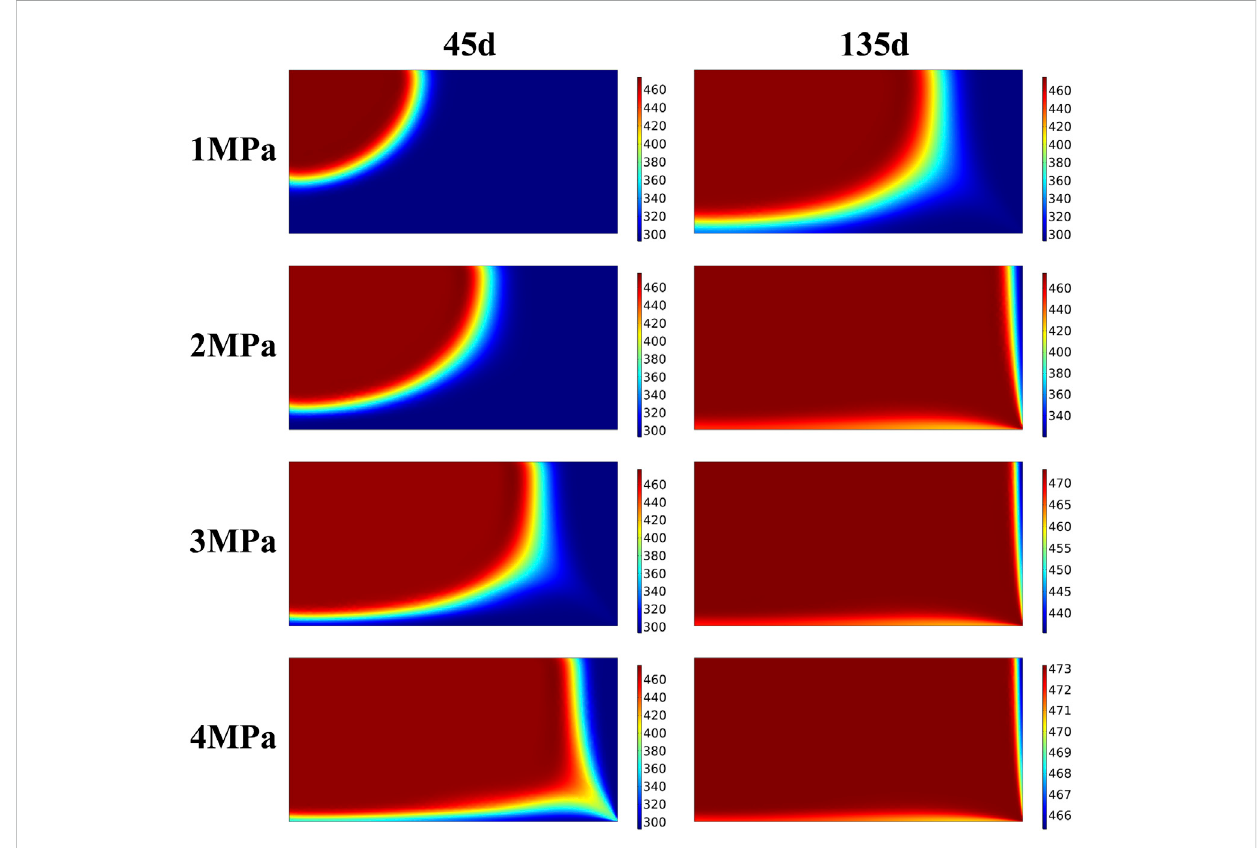
FIGURE 9 Temperature distribution of the system during heat injection at different injection